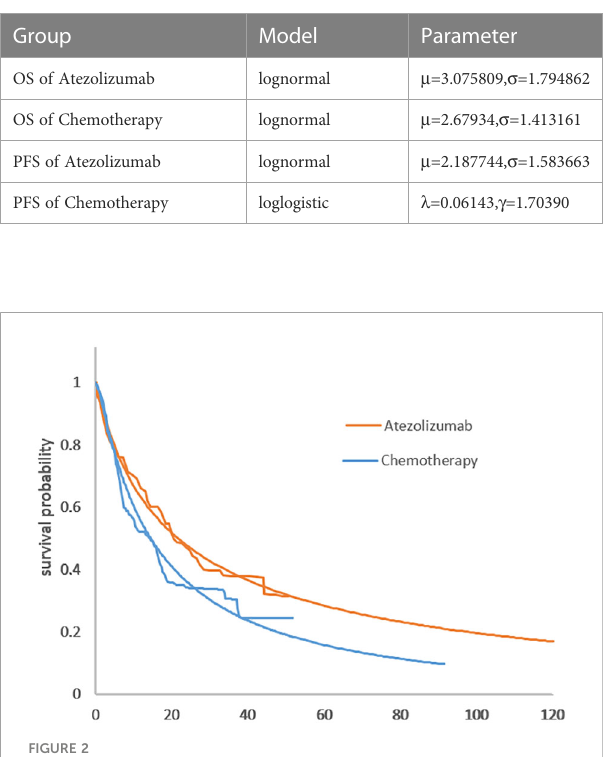
FIGURE 2 (A) Comparison of the adopted fi tting curves and the KM survival curve of IMpower110. (A) PFS curve. (B) Comparison of KM survival curves with the fi tting curve employed in IMpower110. (B) OS curve.